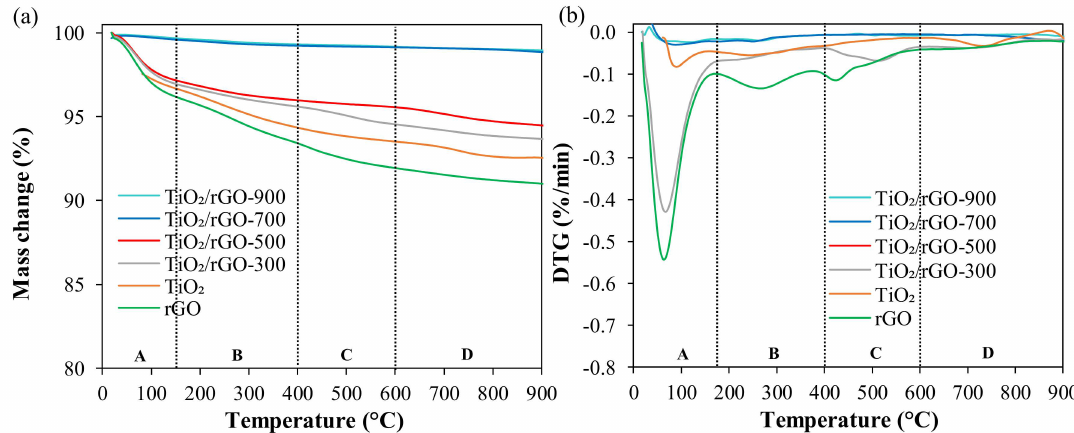
Figure 6. TG ( a ) and DTG ( b ) curves for control and obtained photocatalysts.